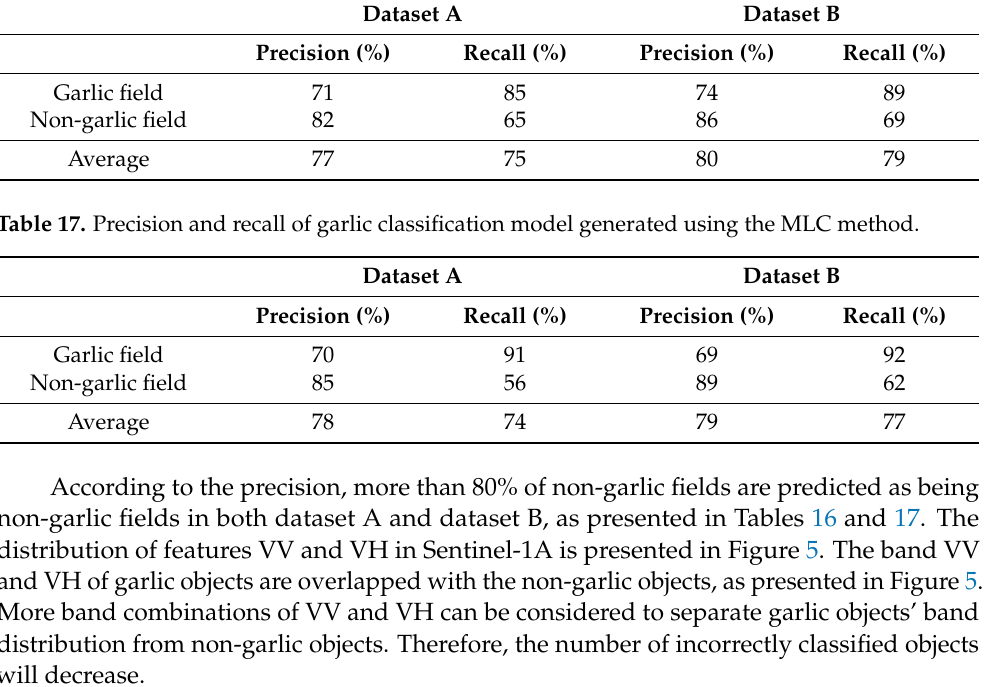
Table 16. Precision and recall of garlic classification model generated using the k -NN method.